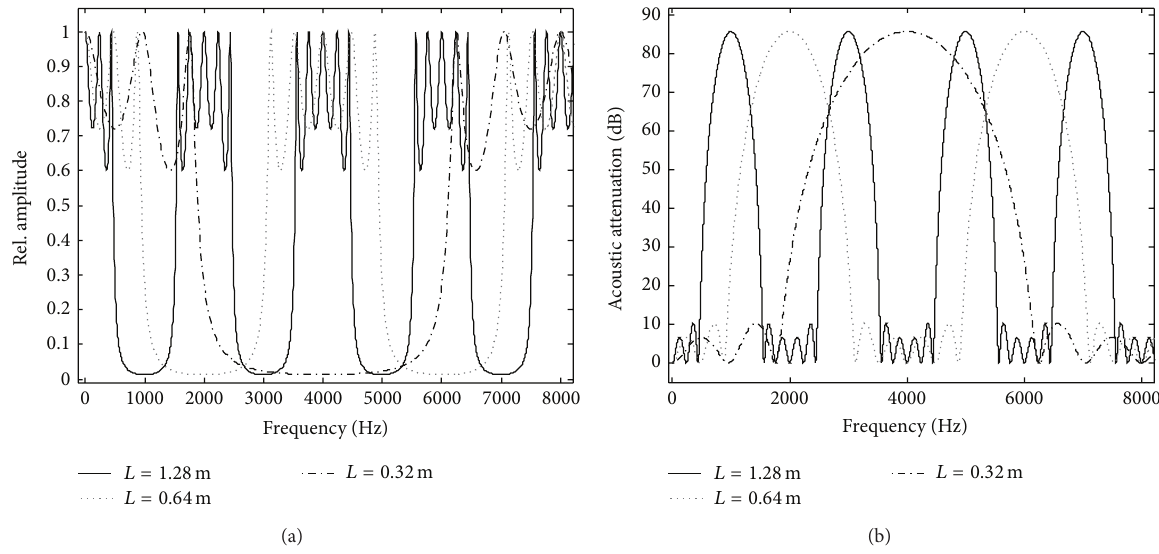
Figure4:Simulationresultsofunitimpulsefrequencyresponseandsoundtransmissionlossfordifferentsingleacousticisolators.(a)Impulse frequency response and (b) sound transmission loss.